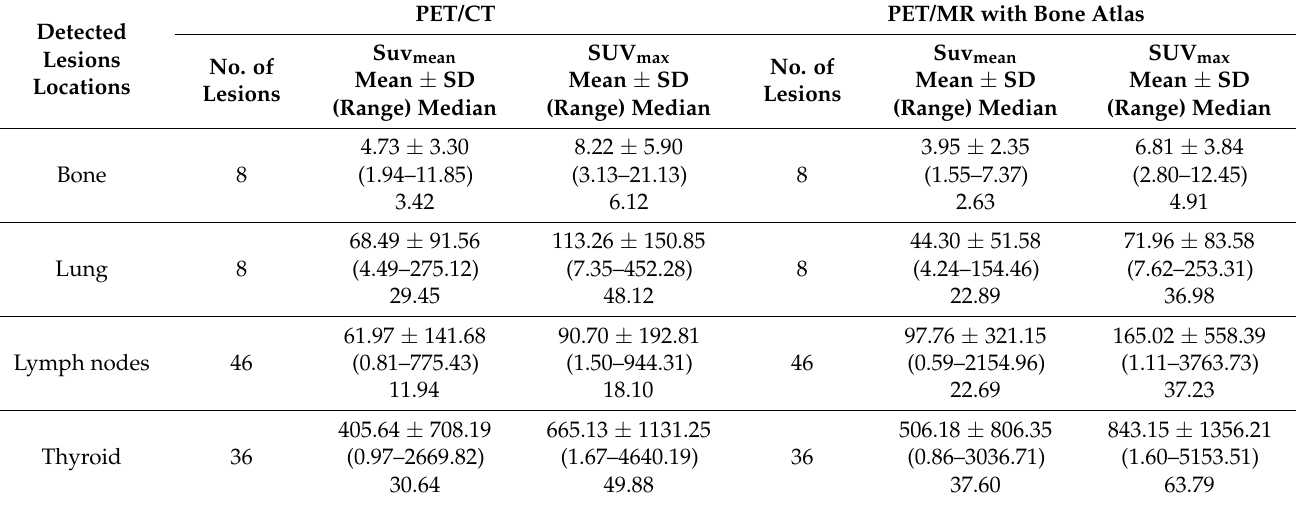
Table 4. Detected iodine-positive lesions and measured standardized uptake values (SUV mean and SUV max ) were sorted according to their location within the patient (lesions close to bone, in the lungs, lymph node lesions, and thyroid lesions) for PET/CT and PET/MR. Note that SUV measures in lesions close to bone or in the lungs are higher in PET/CT than PET/MR, while SUV measures in lymph node lesions or the thyroid are higher in PET/MR than